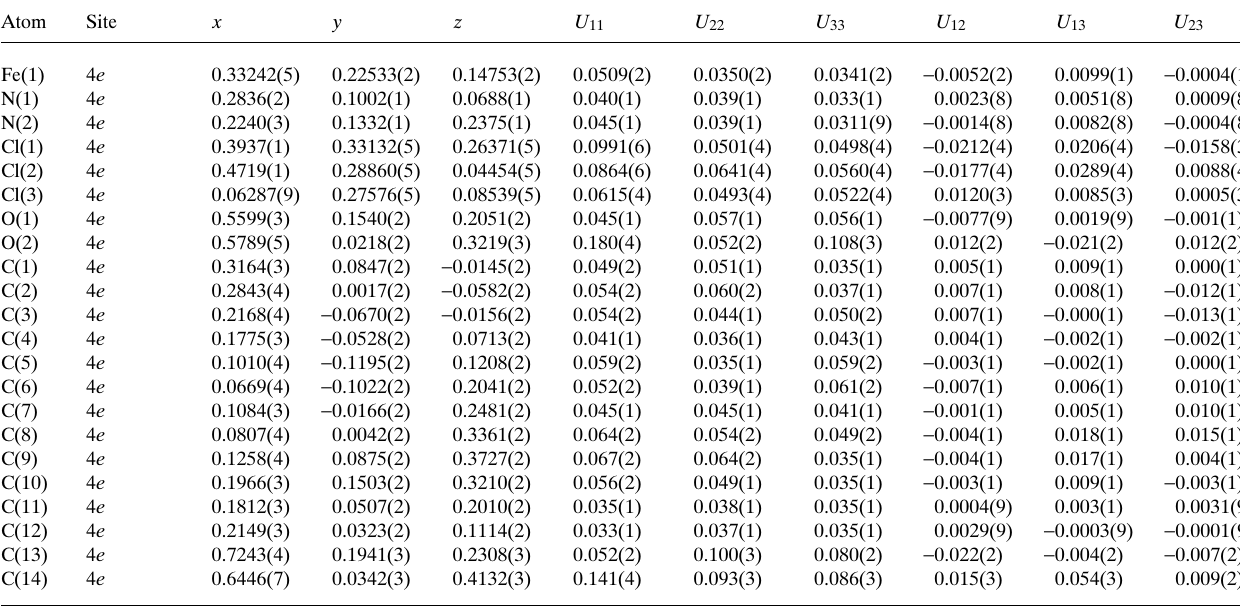
Table 3. Atomic coordinates and displacement parameters (in Å 2 ) .